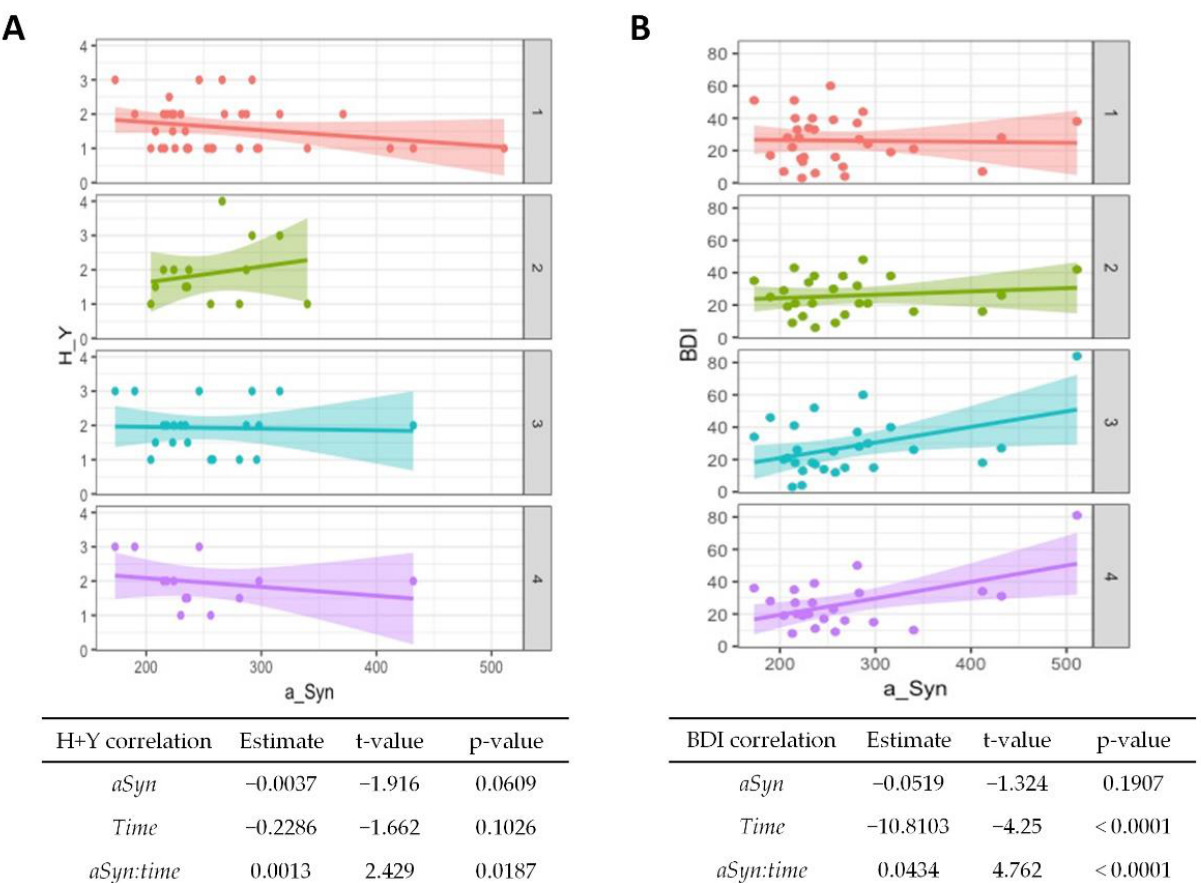
Figure 2. Association of α -synuclein with disease progression and affective symptoms in PD. Correlations from mixed linear regression are displayed by scatter plots with regression lines at baseline (1, red plot), 6 months (2, green plot), 12 months (3, turquoise plot), and 24 months (4, purple plot). Estimates, t-values, and p -values refer to the correlation of Hoehn and Yahr (H + Y) stage ( A ) and Beck Depression Inventory (BDI) scores ( B ) with α -synuclein ( αSyn ), changes in the stage/score over time ( time ), and to the correlation of baseline CSF α -synuclein with changes in stage/score over time ( αSyn:time ). The CSF α -synuclein levels showed no significant association with clinical scales at baseline, but a higher value at baseline was associated with an increase in the Hoehn and Yahr stage with passing time ( p = 0.02, Figure 2A). Higher baseline values were also asso- ciated with poorer BDI results over time ( p < 0.001, Figure 2B), although the overall test score generally improved. 3.3. Association of CSF α -Synuclein Levels and Cognitive Decline in PD Regarding baseline results from the CERAD cognitive test battery, worse perfor- mances of semantic verbal fluency ( p = 0.01, Figure 3A) and word list savings ( p = 0.04, Supplementary Table S 1) were associated with higher α -synuclein levels. The perfor- mance in the Boston Naming Test generally improved over time ( p = 0.002, Figure 3B) but higher α -synuclein at baseline was associated with worse performance at follow-up ( p = 0.002). An association of higher baseline α -synuclein and worse performance at follow- ups was also observed for the Trail Making Test A (Figure 3C, p = 0.02) and the Trail Mak- ing Test B (Figure 3D, p = 0.04). A summary of the CERAD item z-scores at baseline and follow-ups is given in Supplementary Table S2.